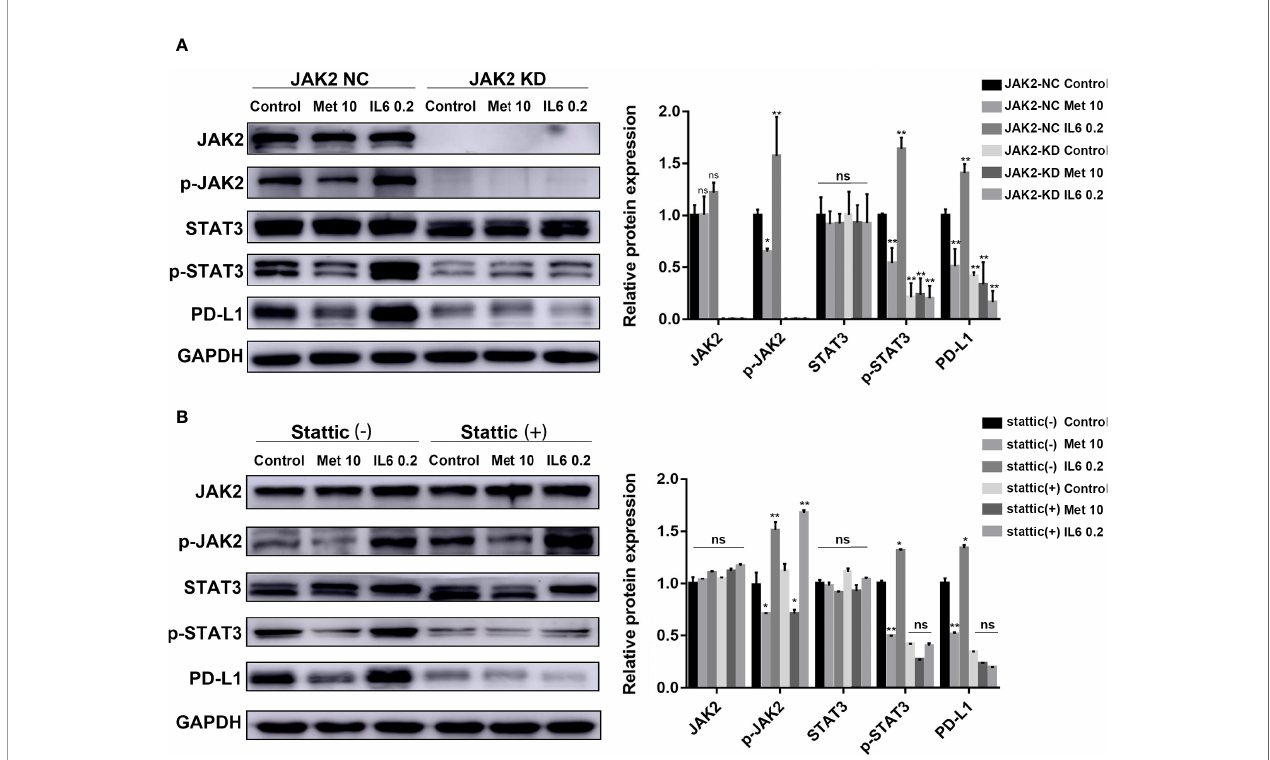
FIGURE 3 | The reduction in PD-L1 expression induced by metformin depends on the IL6/JAK2/STAT3 signaling pathway. (A) KYSE-450 (JAK2 NC) and KYSE450 (JAK2 KD) cells were treated with metformin (10 mM), IL-6 (0.2 ng/ml) or PBS for 36 (h). (B) KYSE-450 cells were pretreated with the STAT3 phosphorylation inhibitor Stattic (5 m M) for 2 h and then treated with metformin (10 mM), IL-6 (0.2 ng/ml) or PBS for 36 (h). Western blot analysis and quanti fi cation of phosphorylated- Jak2 (p-Jak2), Jak2, phosphorylated- Stat3 (p-Stat3), Stat3, PD-L1, and GAPDH were performed. Error bars represent the standard deviation. *p < 0.05, **p < 0.01; ns, no signi fi